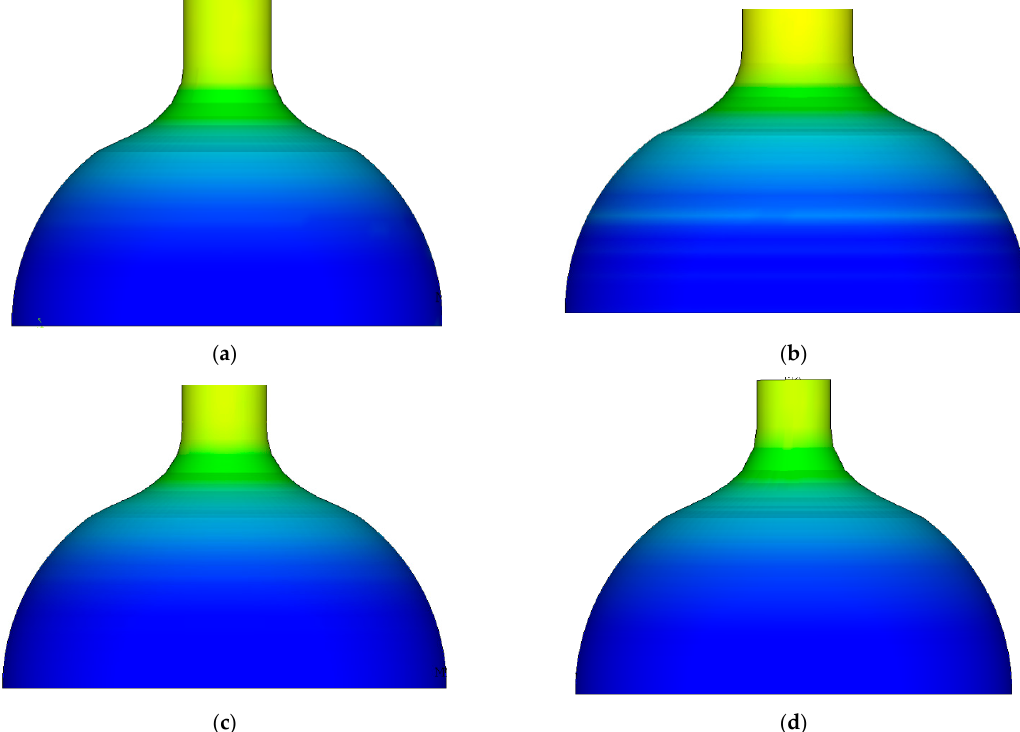
Figure 3. The cloud diagram of equivalent strain distribution after spinning at different temperatures. ( a ) Equivalent strain distribution map at 800 °C. ( b ) Equivalent strain distribution map at 900 °C. ( c ) Equivalent strain distribution map at 1000 °C. ( d ) Equivalent strain distribution map at 1100 °C.